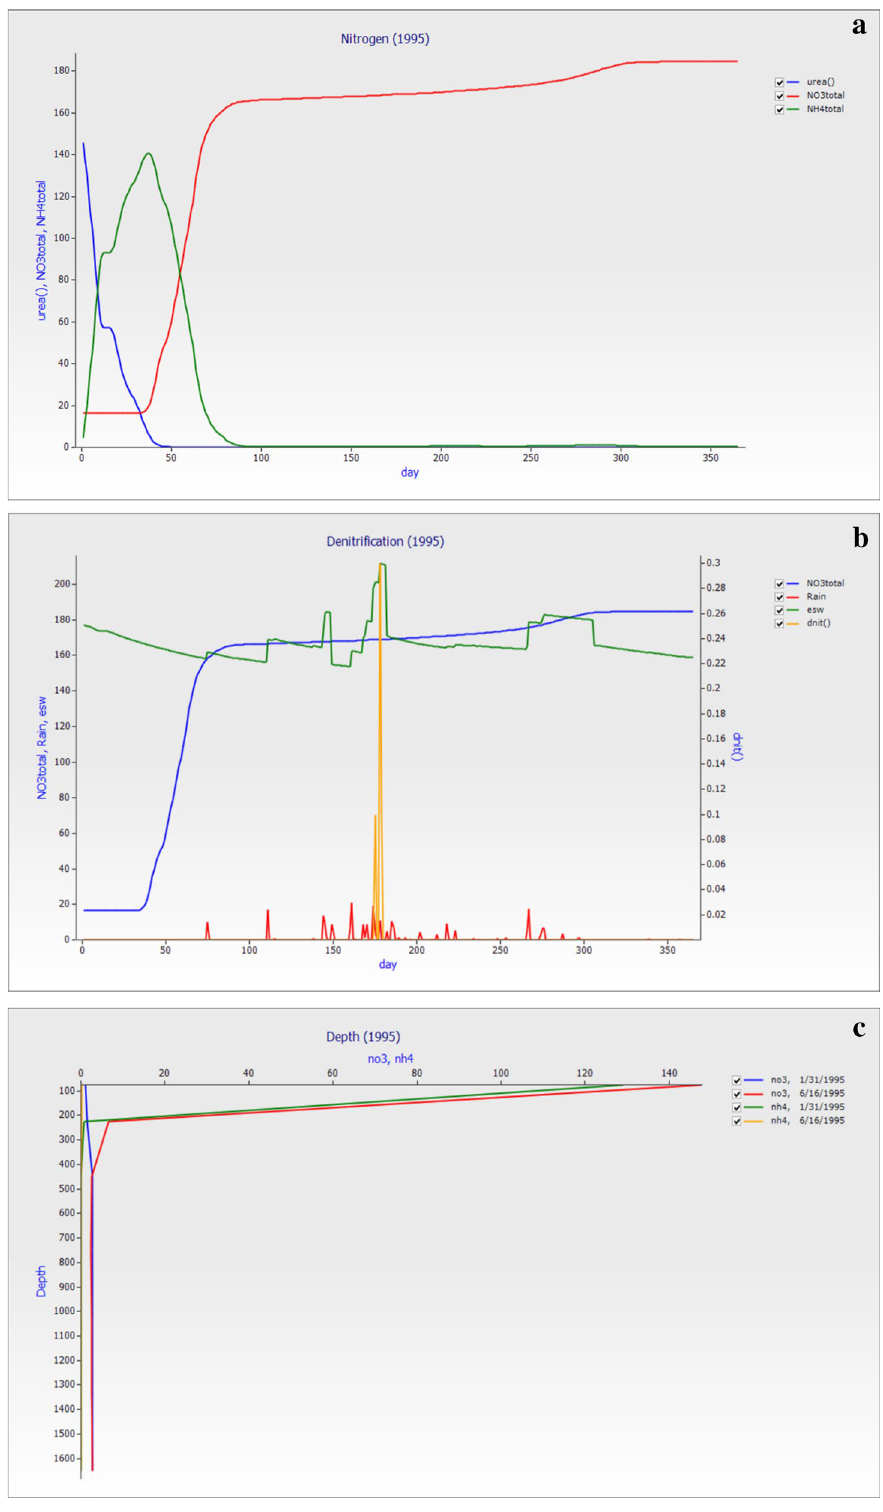
Figure 6. The graph of the year 1995 ( a ) between rain versus urea, NO 3− –N and NH 4+ –N showed that the long-term fertilization effect on dynamic of nitrogen in the soil, ( b ) day versus total NO 3− –N, Rain, Essential soil water (esw), total NH 4+ –N and rainfall in 1995 while ( c ). The losses (NO 3− –N and NH 4+ –N) with different depths showed that NO 3− –N losses depend on the rainfall events at different dates of the